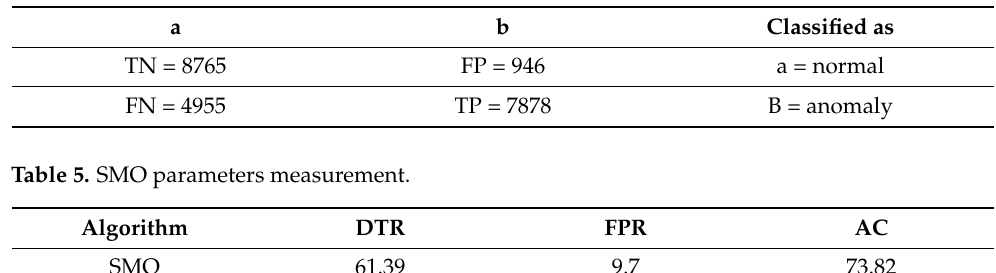
Table 4. Confusion matrix for SMO.